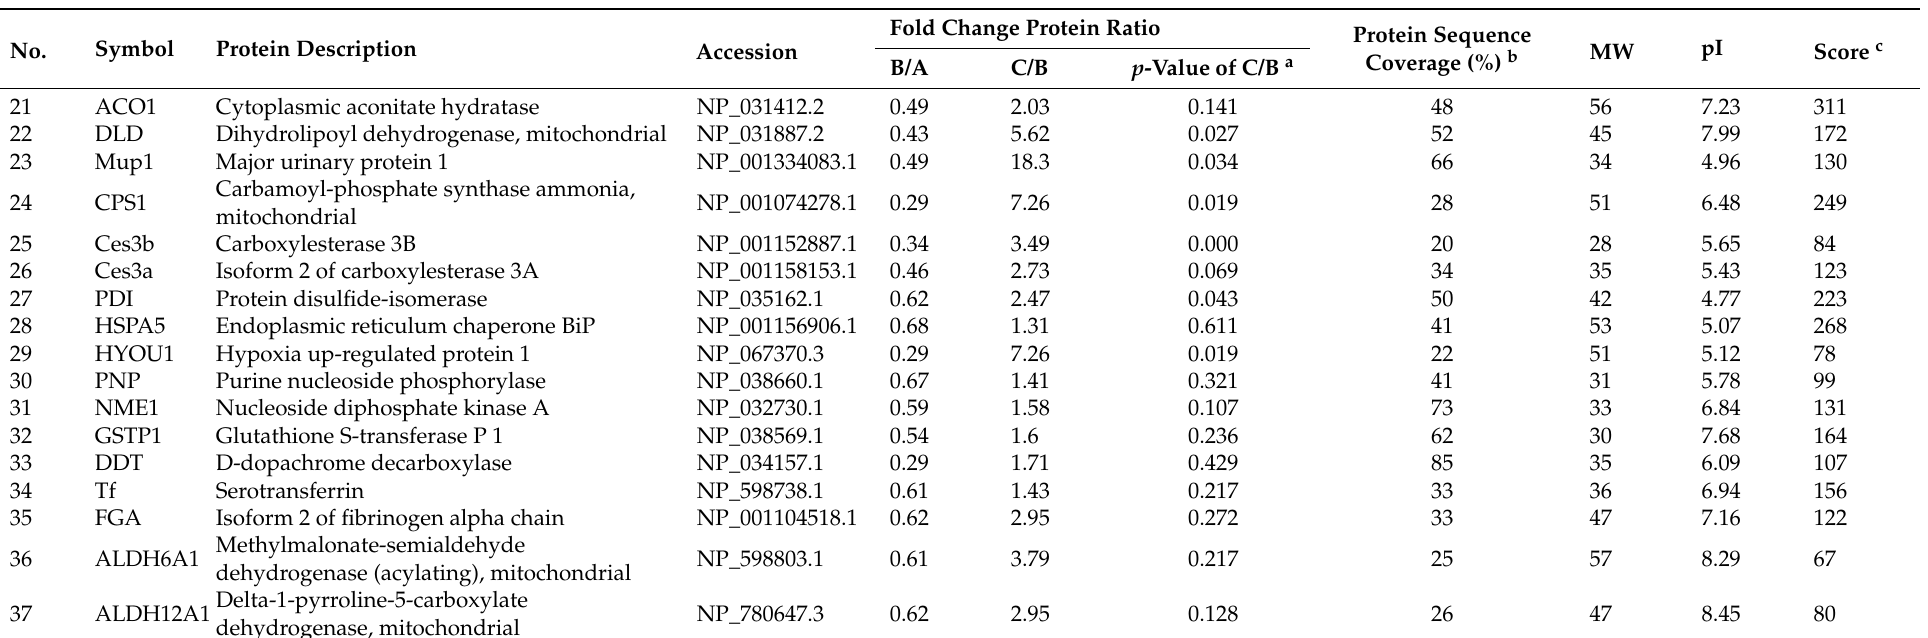
Table 2. Effects of TMP on the proteins down-regulated by the high-fat diet.